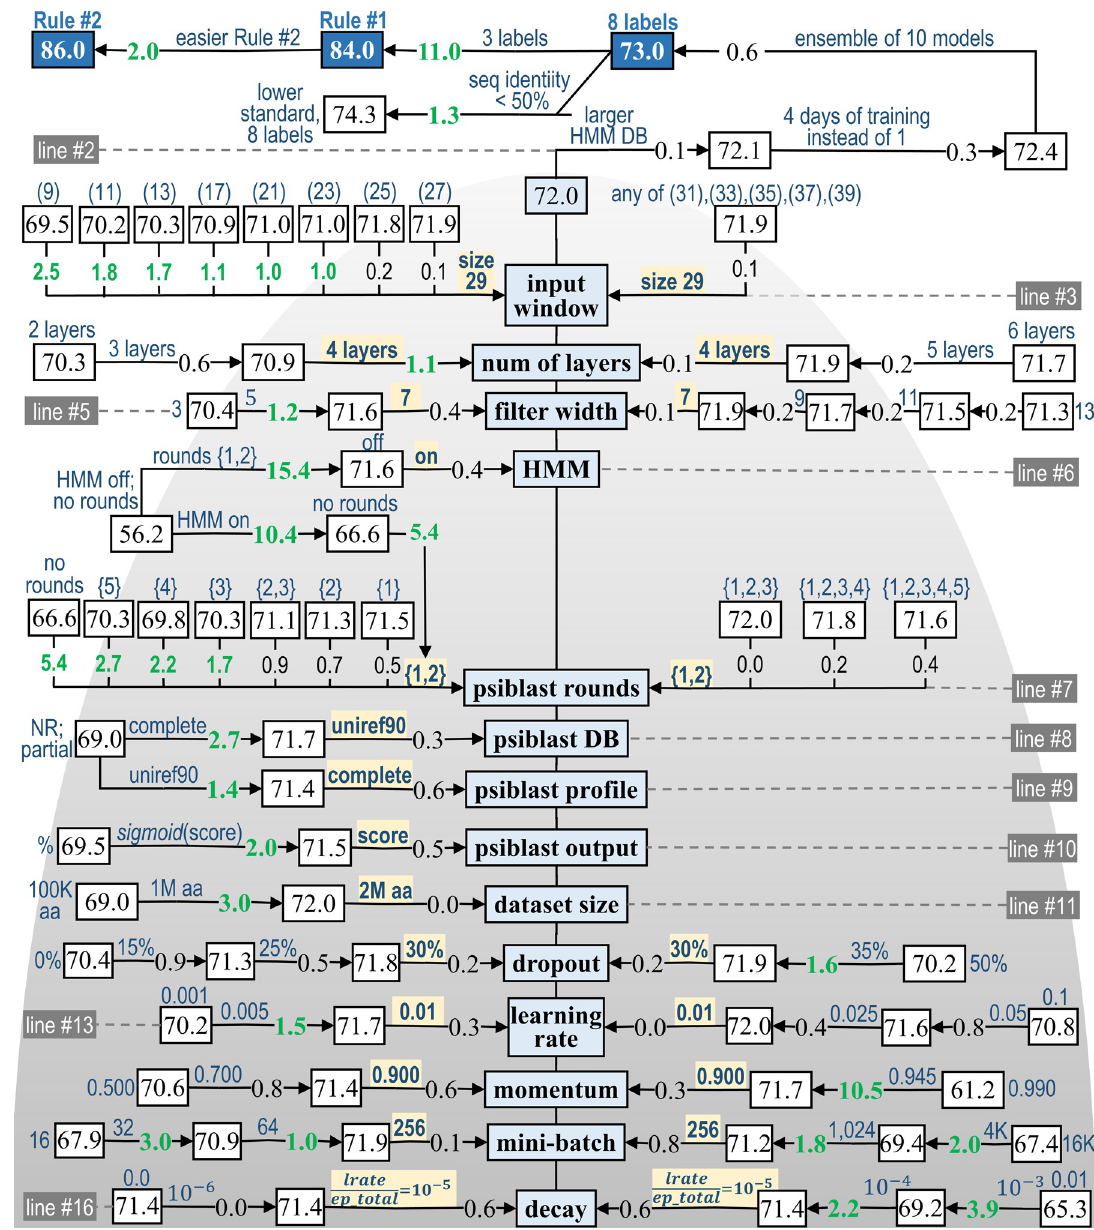
Fig 4. Ablation study of Test2018 accuracy of SecNet . Accuracy is presented as a function of factors (blue boxes in the middle) from 3 groups: 1) NN architecture and complexity (top); 2) input features and databases (center); and 3) hyper-parameters of the training pipeline (bottom). The test accuracies displayed in black uncover unbiased estimates for publication purposes after all choices of the final model parameters were made; the validation set was used to make these choices of hyper-parameters using our optimization strategy. Lines 1–2 : Actions such as “4-day training” or “ensemble of 10 cross-validated models” led to further improvement. Line 1 : The accuracy increases with switch of 8 ! 3 labels by replacing a harder Rule #1 to easier Rule #2 and with a weaker 25% ! 50% maximal sequence identity between the test and training sets. Each arrow indicates a direction of favorable parameter change and embeds associated accuracy gain. Parameter values are in blue. The optimal parameter values are highlighted in yellow and shown in the middle with smaller and larger values on the left and right. The cumulative effect from multiple changes of the same hyper-parameter is a sum of individual accuracy increments (in black). Stronger effects ( � 1 point) are shown in green. The accuracy is a non-linear function of hyper-parameters; an effect from a change of multiple hyper-parameters is not the sum of the accuracy increments associated with the different hyper-parameter changes while the remaining parameters are fixed.